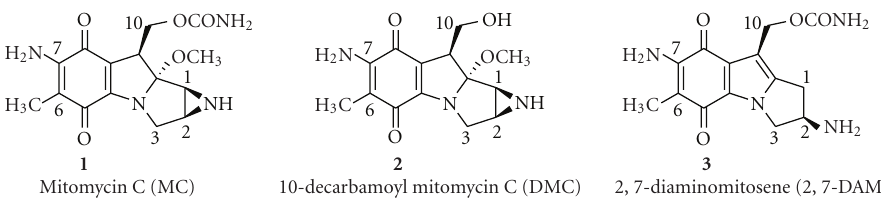
Figure 1: Chemical structures of MC, DMC, and 2,7-DAM. (Reproduced with permission from Chem. Res. Toxicol. 2008, 21 , 2370).